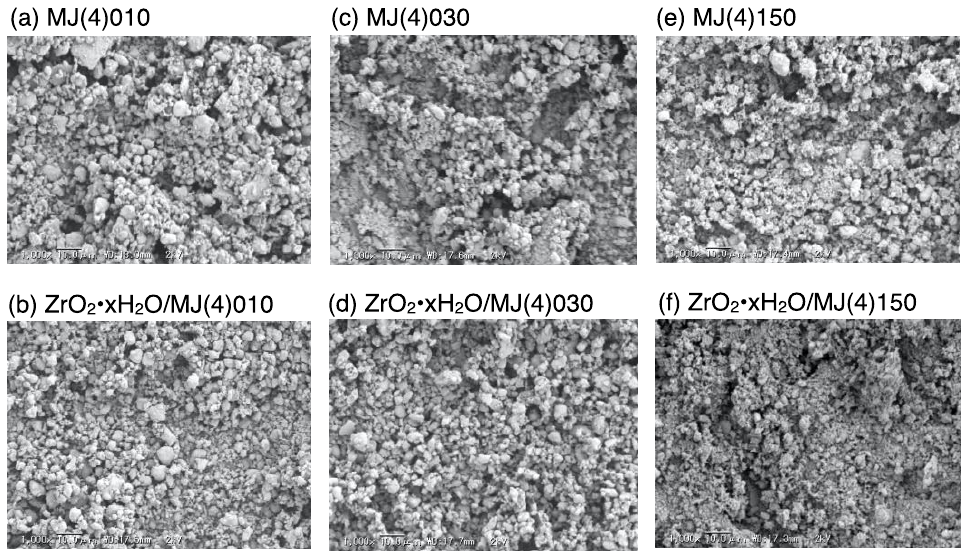
Figure 3. SEM images of the prepared adsorbents and the unmodified carbons: MJ(4)010 ( a ), ZrO 2 · xH 2 O / MJ(4)010 ( b ), MJ(4)030 ( c ), ZrO 2 · xH 2 O / MJ(4)030 ( d ), MJ(4)150 ( e ), and ZrO 2 · xH 2 O / MJ(4)030 ( f ).